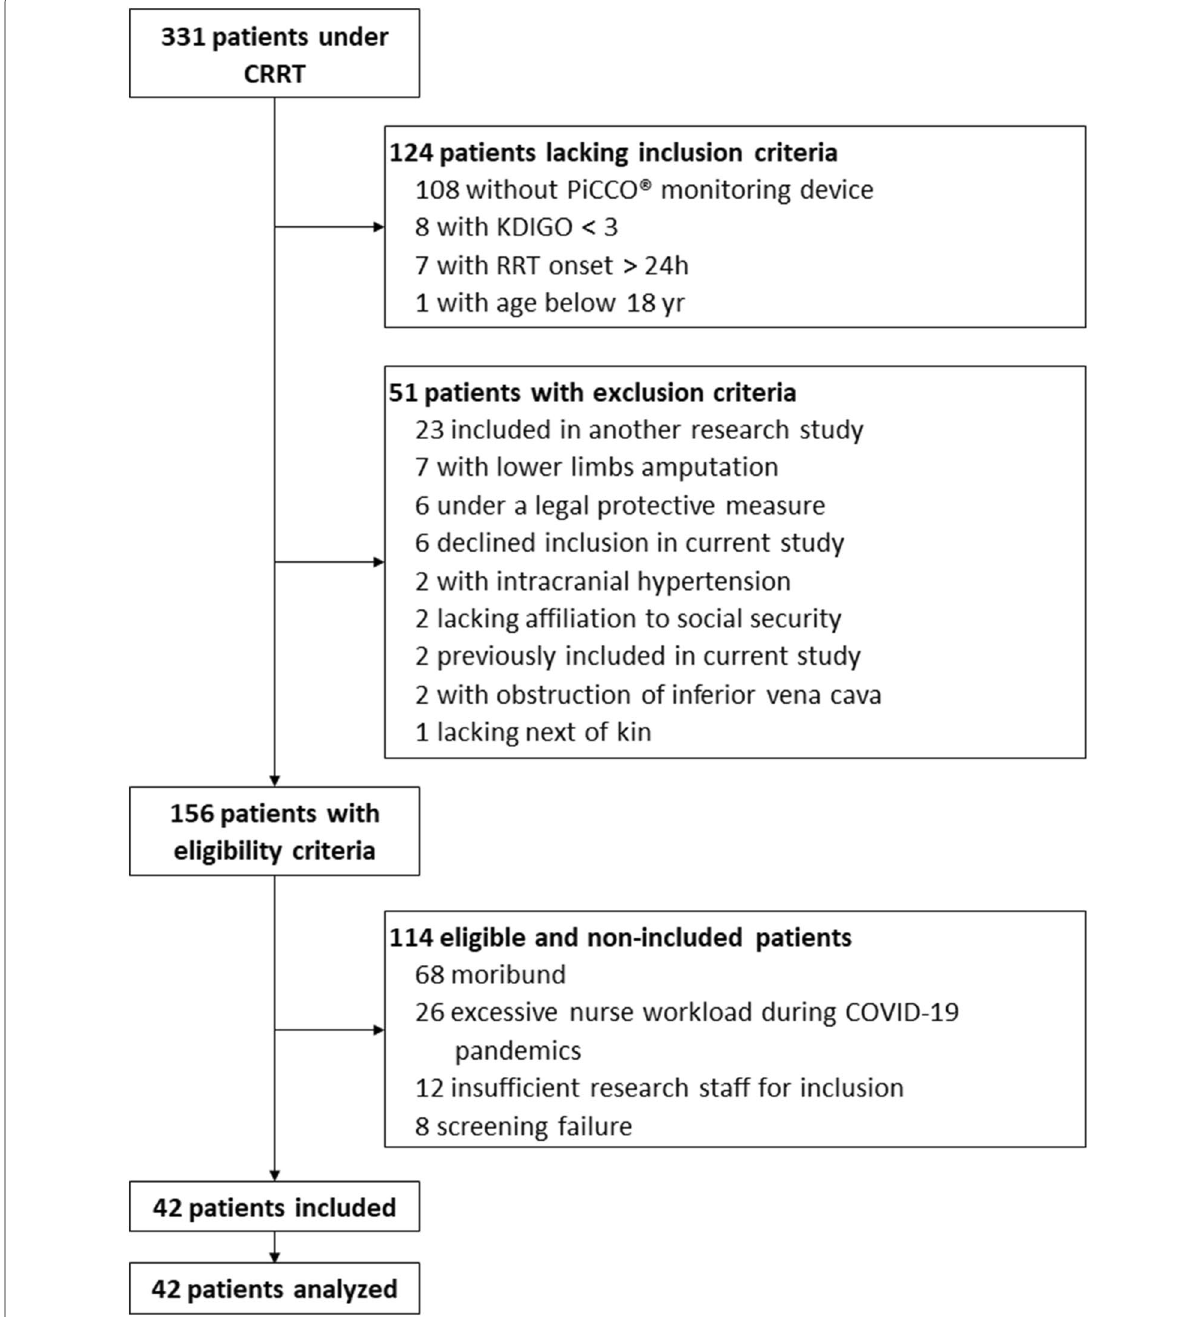
Fig. 1 Study flowchart. CRRT continuous renal replacement therapy, RRT renal replacement